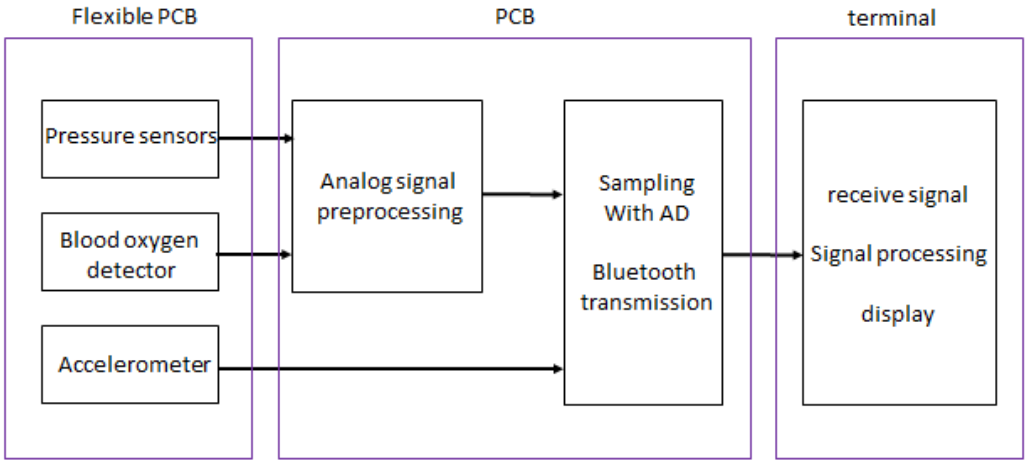
Figure 4. The block diagram of the monitoring system.